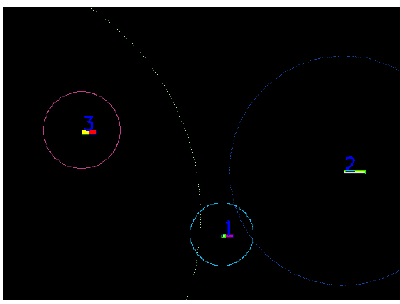
Figure 9. First step of the data association algorithm. In this image, three detected objects and their tracks along with their covariance ellipses are shown.